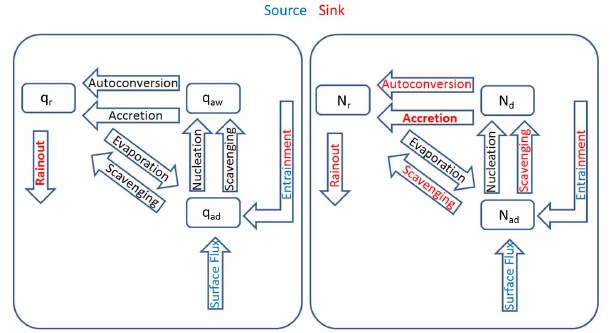
Fig. 1. Block diagram of processes changing the reservoirs of aerosol mass (left) and number (right) in our bulk aerosol scheme; colors indicate processes that are MBL-mean source or sinks (En- trainment is shown in both colors since it can be either a source or sink.)